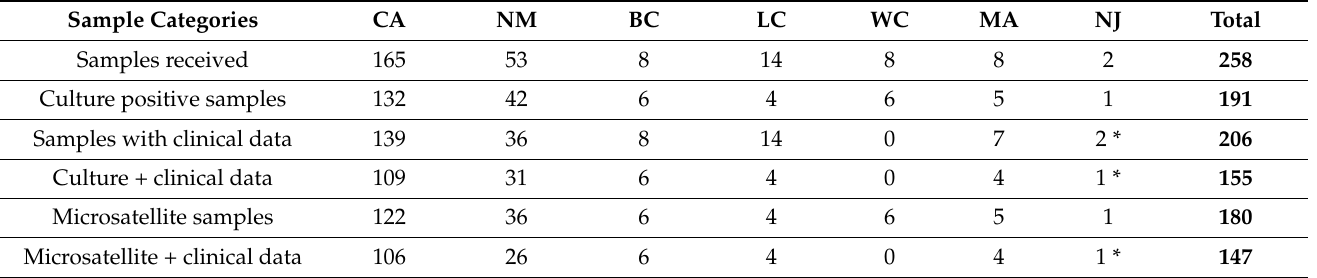
Table 2. One hundred forty-seven samples were included in microsatellite analysis associated with reported clinical attributes.